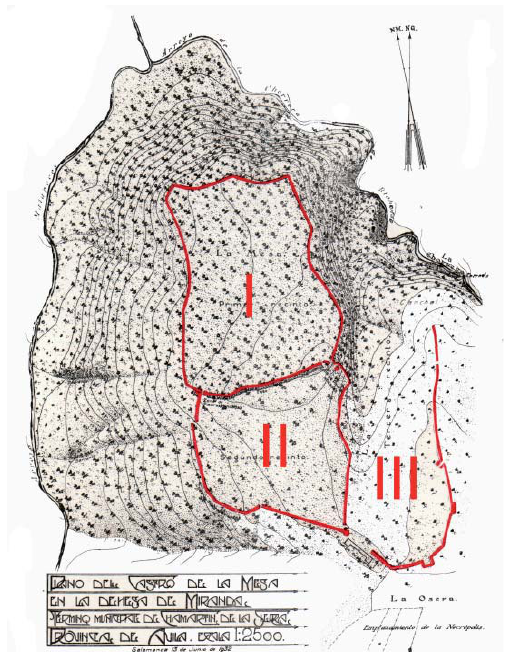
Figure 1. Topographic map of the hillfort. The three enclosures are marked in red. From Baquedano and Martín